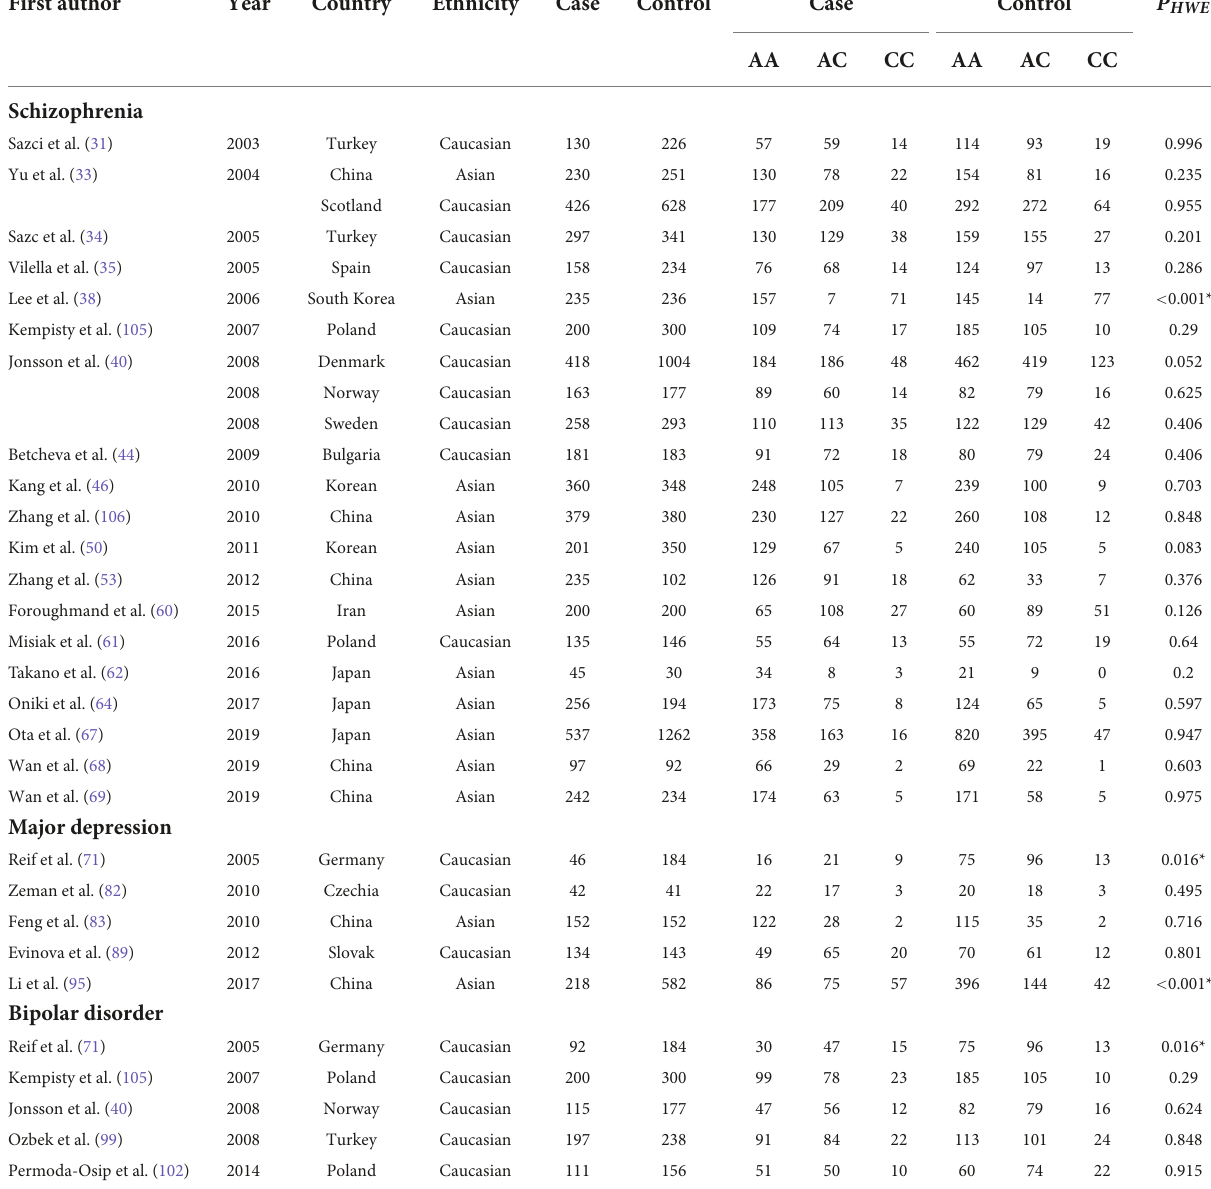
TABLE 2 Overview of MTHFR A1298C genotype distribution of psychosis patients and controls, with information about country, ethnicity, and